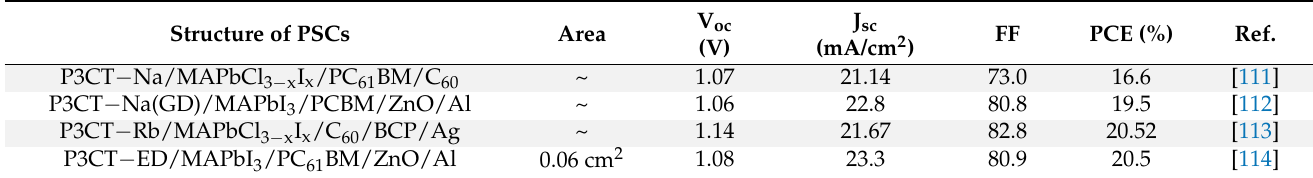
Table 8. Performances of several representative inverted PSCs on the basis of the different polyelec- trolyte HTL structures.